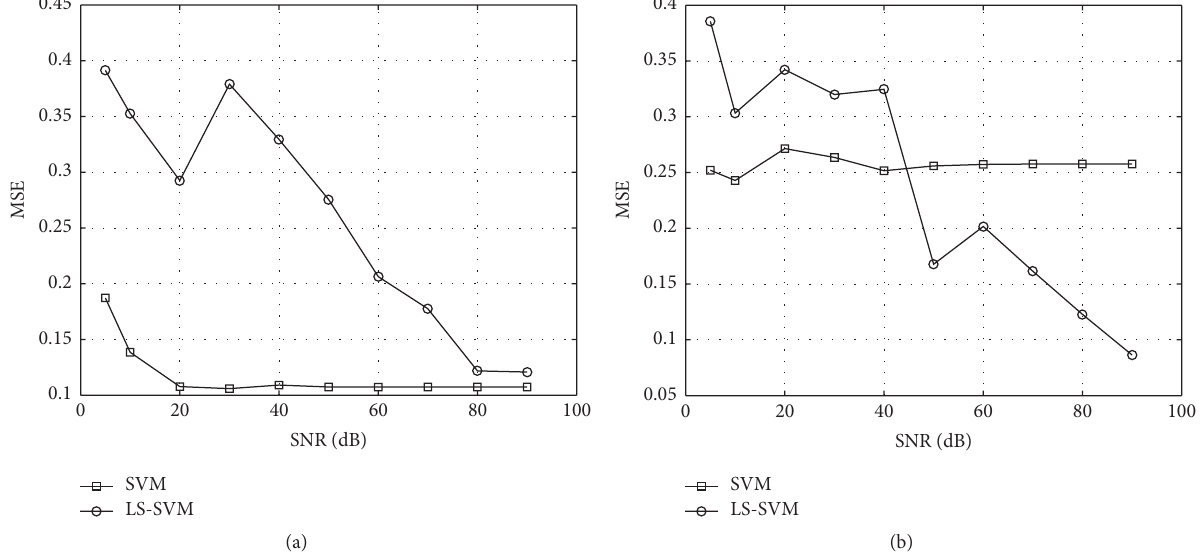
Figure 8: MSE as a function of SNR for (a) horizon and (b) depth of the target